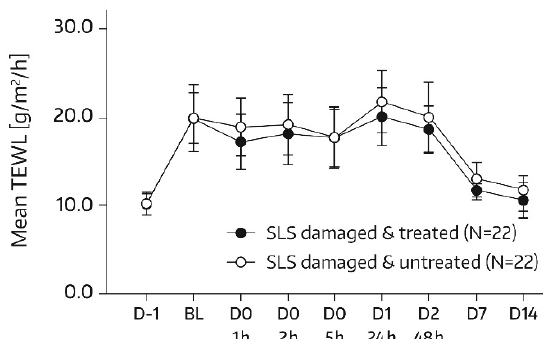
Figure 7. Results from TEWL measurements in untreated SLS-damaged skin and SLS-damaged skin undergoing a single application of Emollient 2 (first 48 h) followed by once-daily application for 12 days. The values are presented as mean ± SD. SLS challenge started on day -1 and ceased 24 h later (30 min before BL assessment). BL = Baseline TEWL value before first product application; D = day; h = hour; SLS = sodium lauryl sulfate.